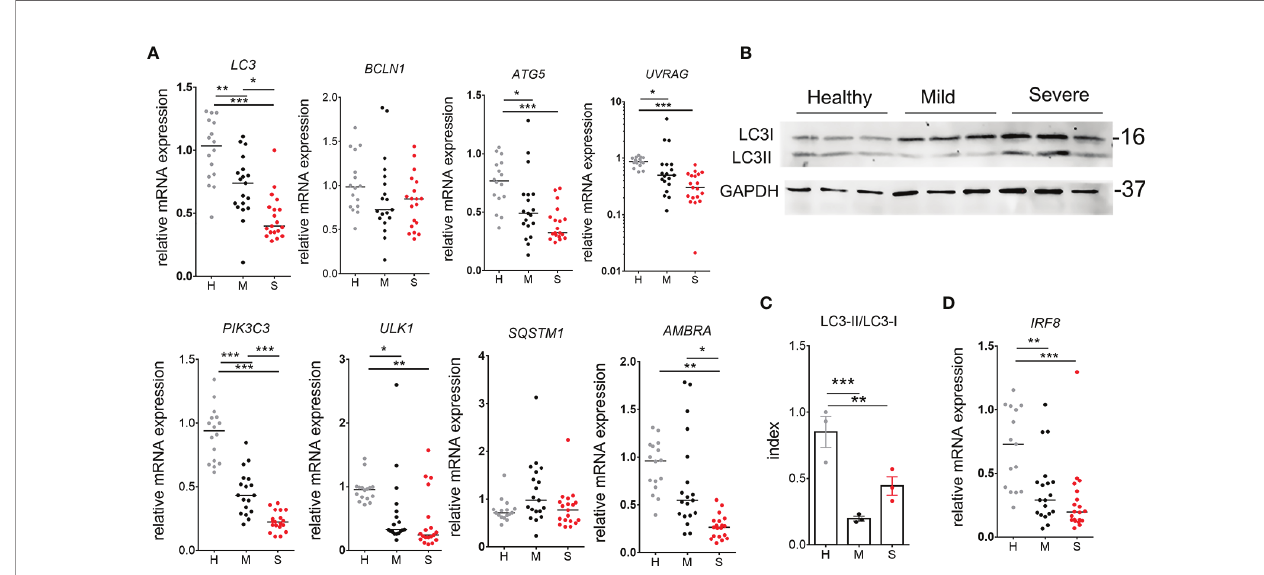
FIGURE 4 | Autophagy analysis in peripheral blood mononuclear cells (PBMC) of coronavirus disease (COVID)-19 patients and healthy donors. (A) Relative mRNA expressions of LC3, BCLN1, ATG5, UVRAG, PIK3C3, UL1, SQSTM1, and AMBRA were analyzed in freshly isolated PBMC of 16 healthy donors (H), 19 mild (M) and 20 severe (S) COVID-19 patients by qPCR. (B) Western blot of LC3I (16kDa), LC3II, and GAPHD (37kDa) is shown, wherein each blot in a column represent a sample prepared by puling equivalent amounts of proteins isolated from PBMC of 5 different donors (totally 15 donors per group). (C) The Index of LC3II/LC3I conversion shown for these samples, was calculated by densitometry. *p < 0.05, **p < 0.01 as indicated (Student t-test). (D) Relative mRNA expression of IRF-8 was analyzed as described in (A) . (A, D) *p < 0.05, **p < 0.01, ***p < 0.005 as indicated (Kruskal-Wallis test with Dunn ’ s